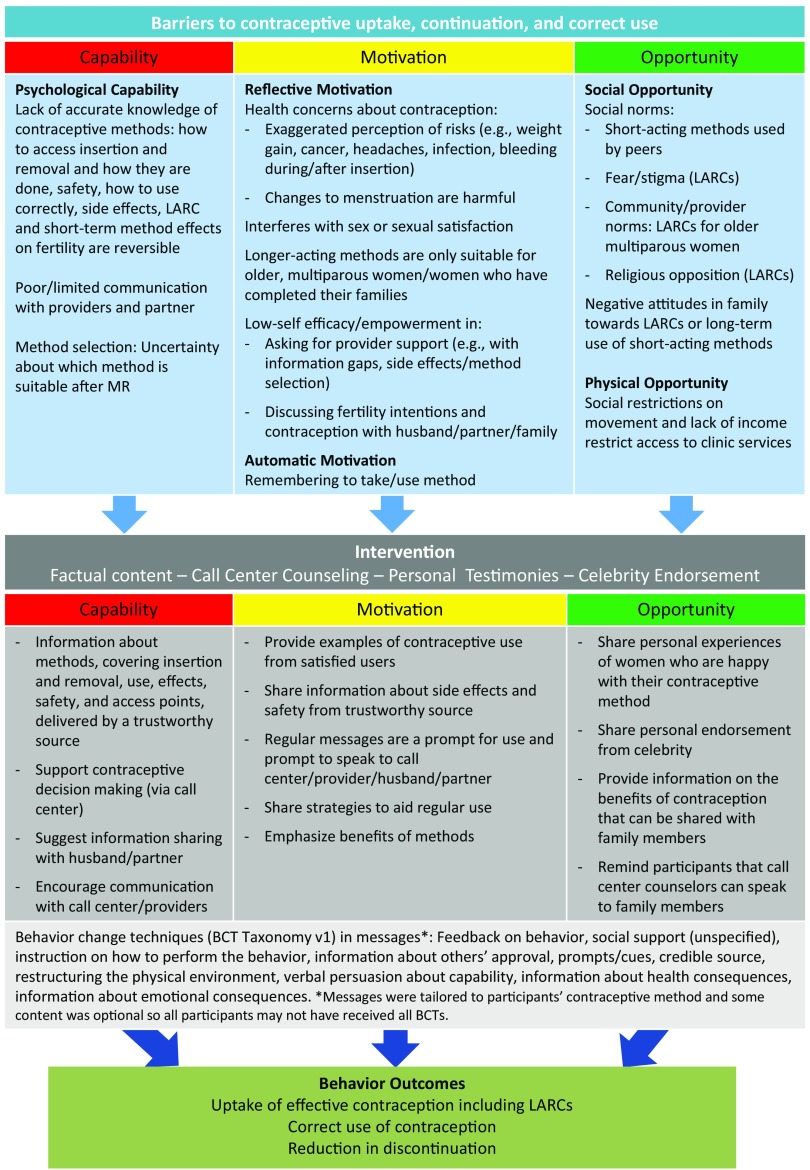
Conceptual Framework for the Mobile Phone Intervention Designed to Support Post-Menstrual Regulation Contraceptive Use in BangladeshAbbreviations: LARC, long-acting reversible contraceptive; MR, menstrual regulation.